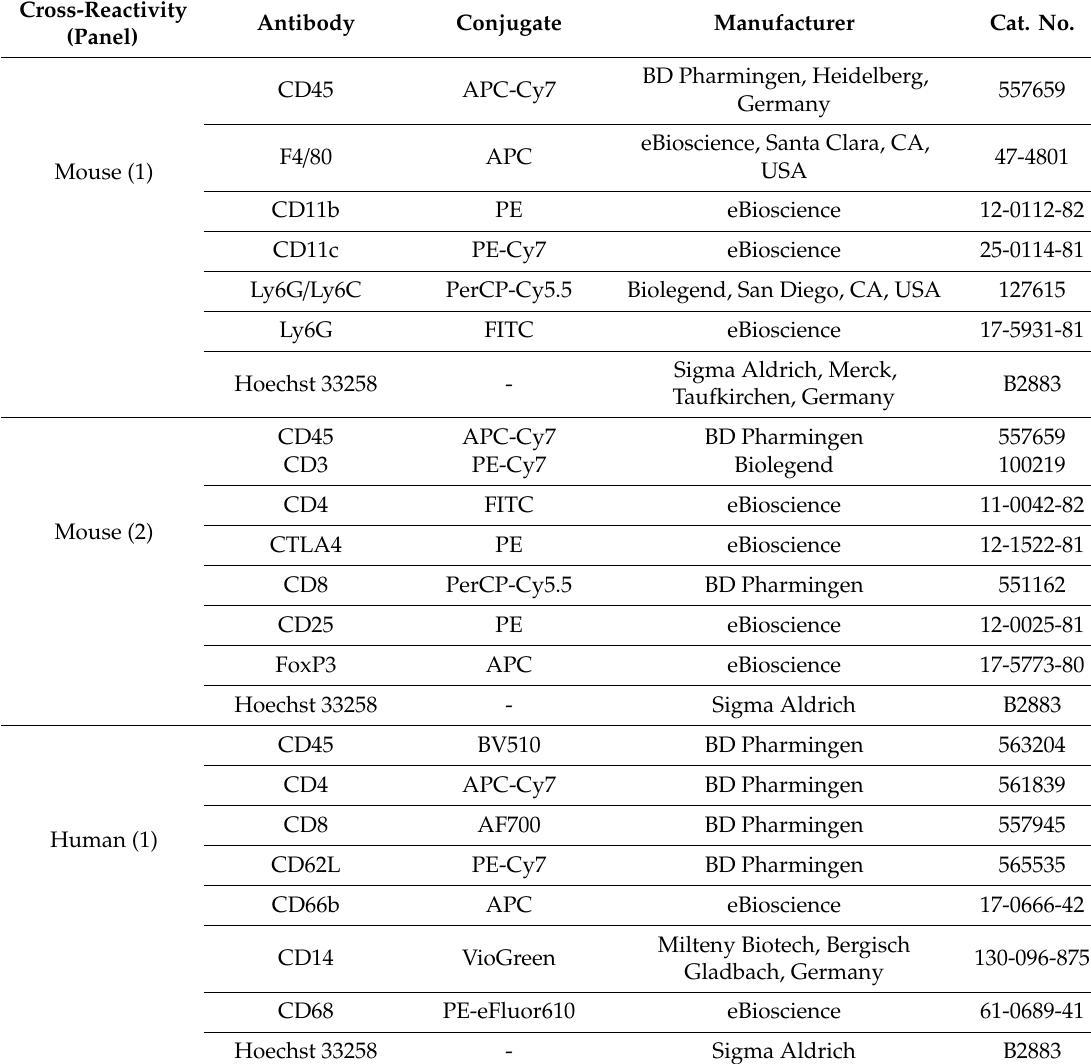
Table 3. Antibody panels used for flow cytometric analysis (FACS)